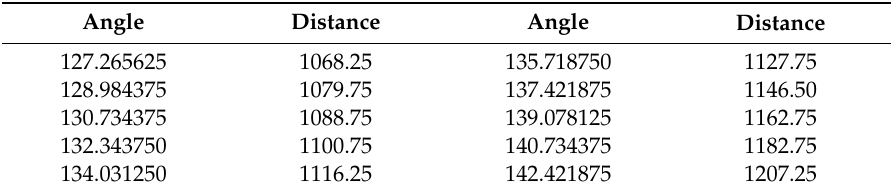
Table 3. Lidar sensor data collected in